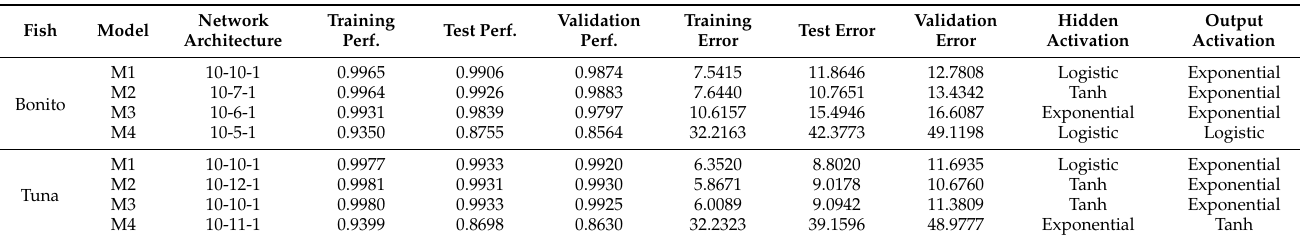
Table 5. Artificial neural network models for histamine prediction for calibration sample sets combined with real sample sets of each fish species. Fish Model